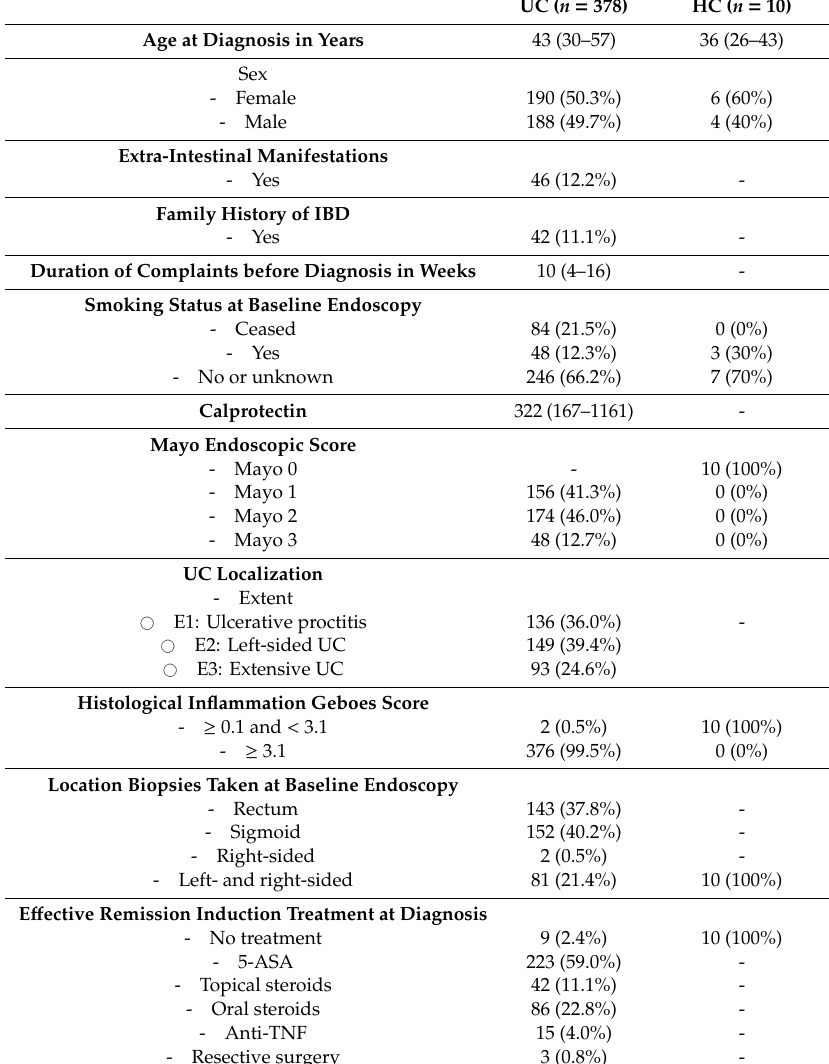
Table 1. Baseline